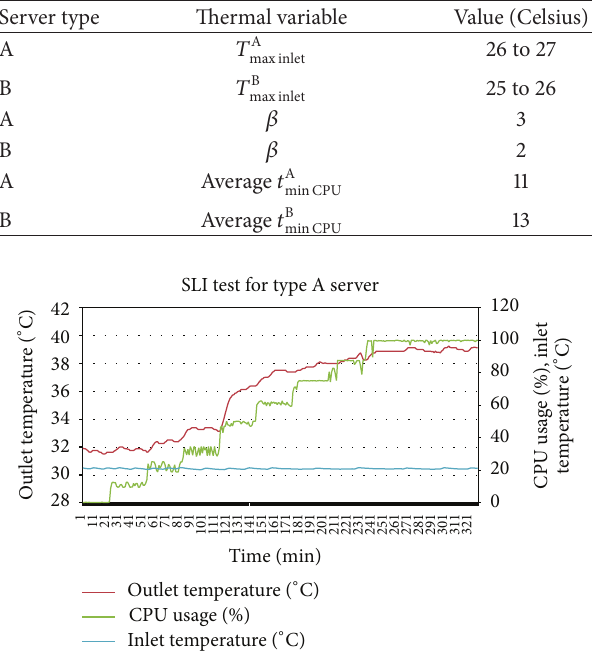
Figure 4: SLI test performed for thermal profiling of type A